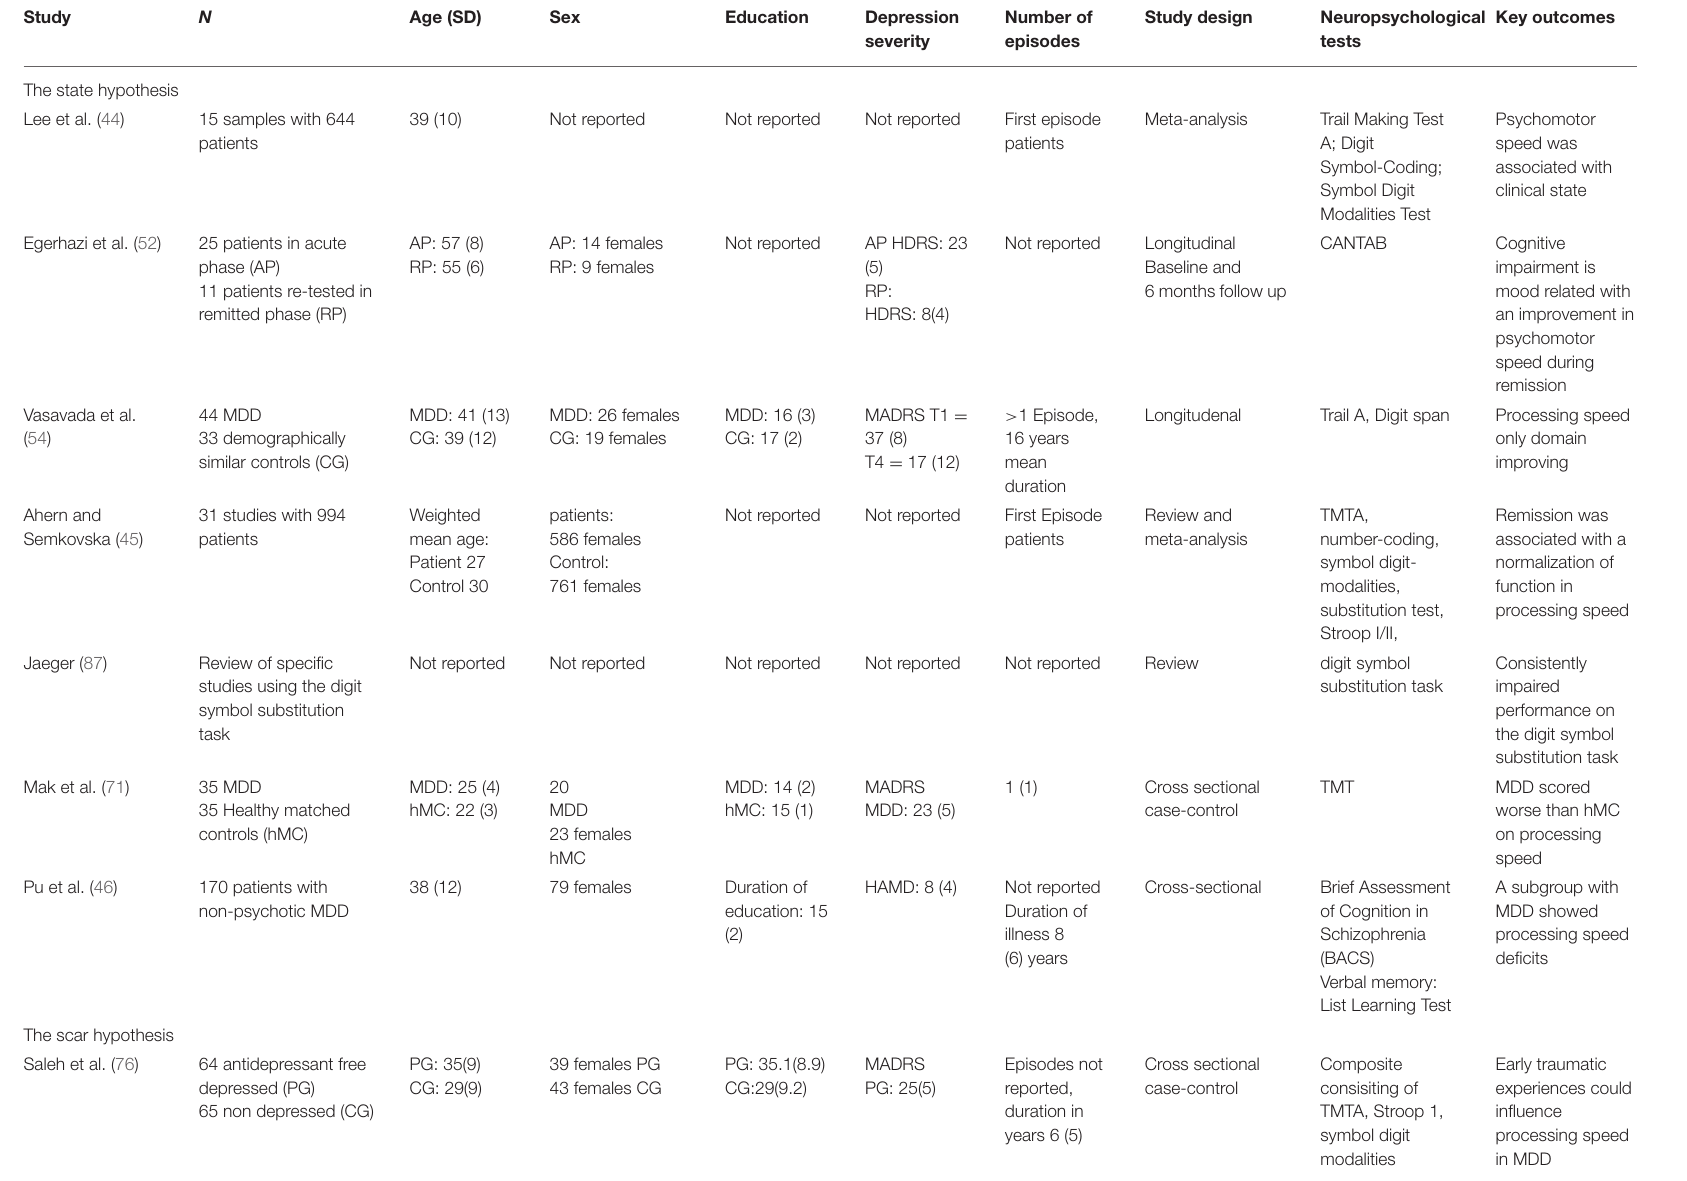
TABLE 4 | Findings within the domain of processing speed regarding origin of